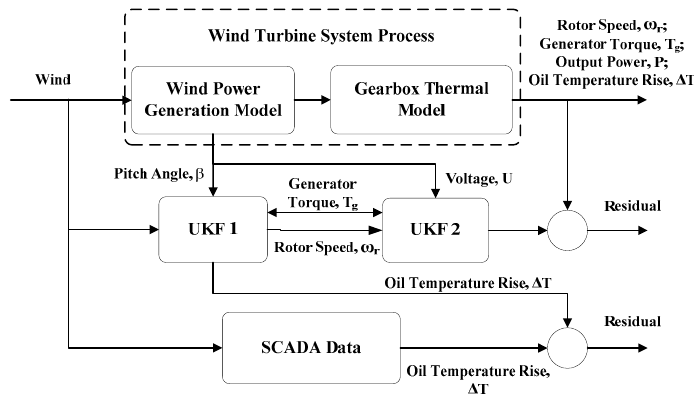
Figure 1. System process of developing quantitative model for wind turbine (WT) fault detection and diagnosis.